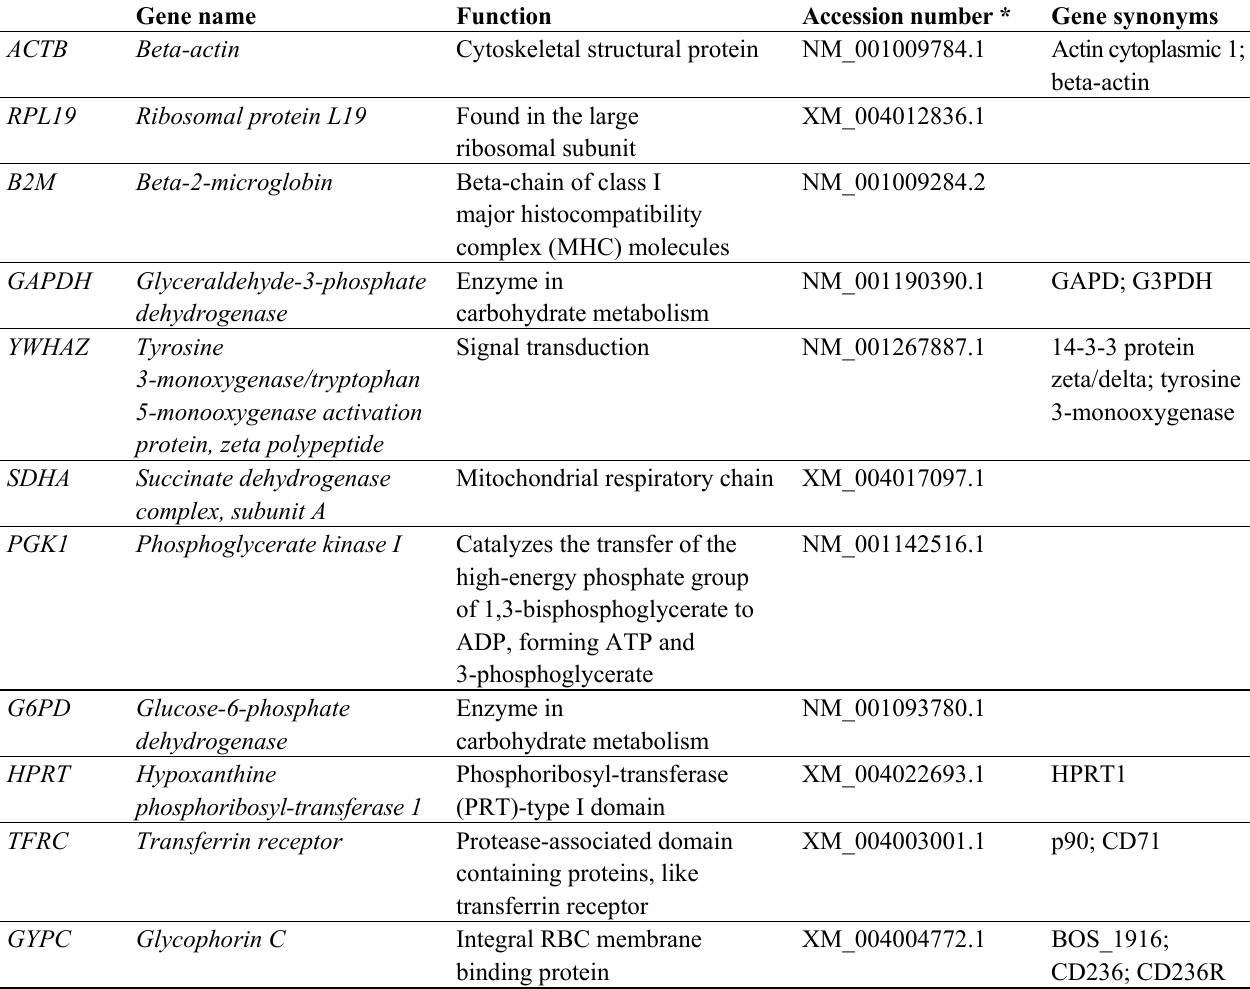
Table 1. Candidate reference genes evaluated in this